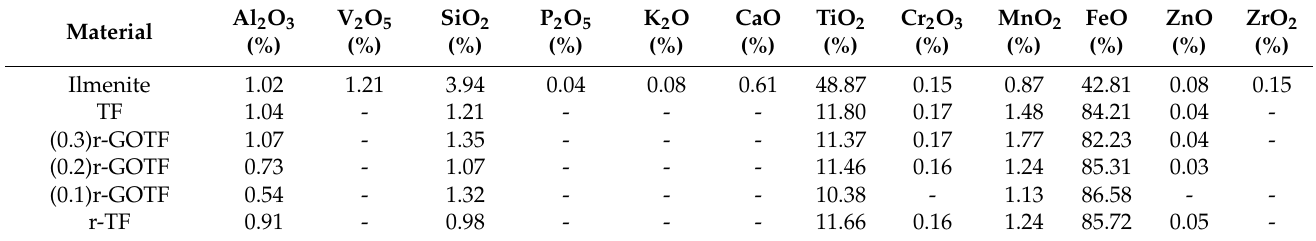
Table 4. XRF analysis of ilmenite sand and fabricated